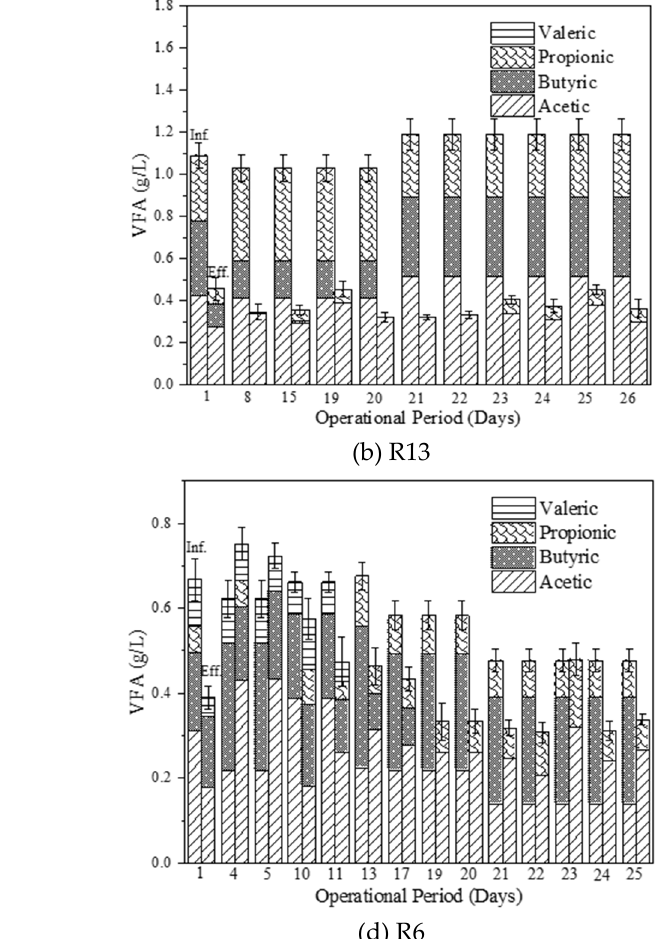
Figure 2. The VFA consumption profile for ( a ) R10, ( b ) R13, ( c ) R14, and ( d ) R6, with individual VFA concentration in influent and effluent samples.